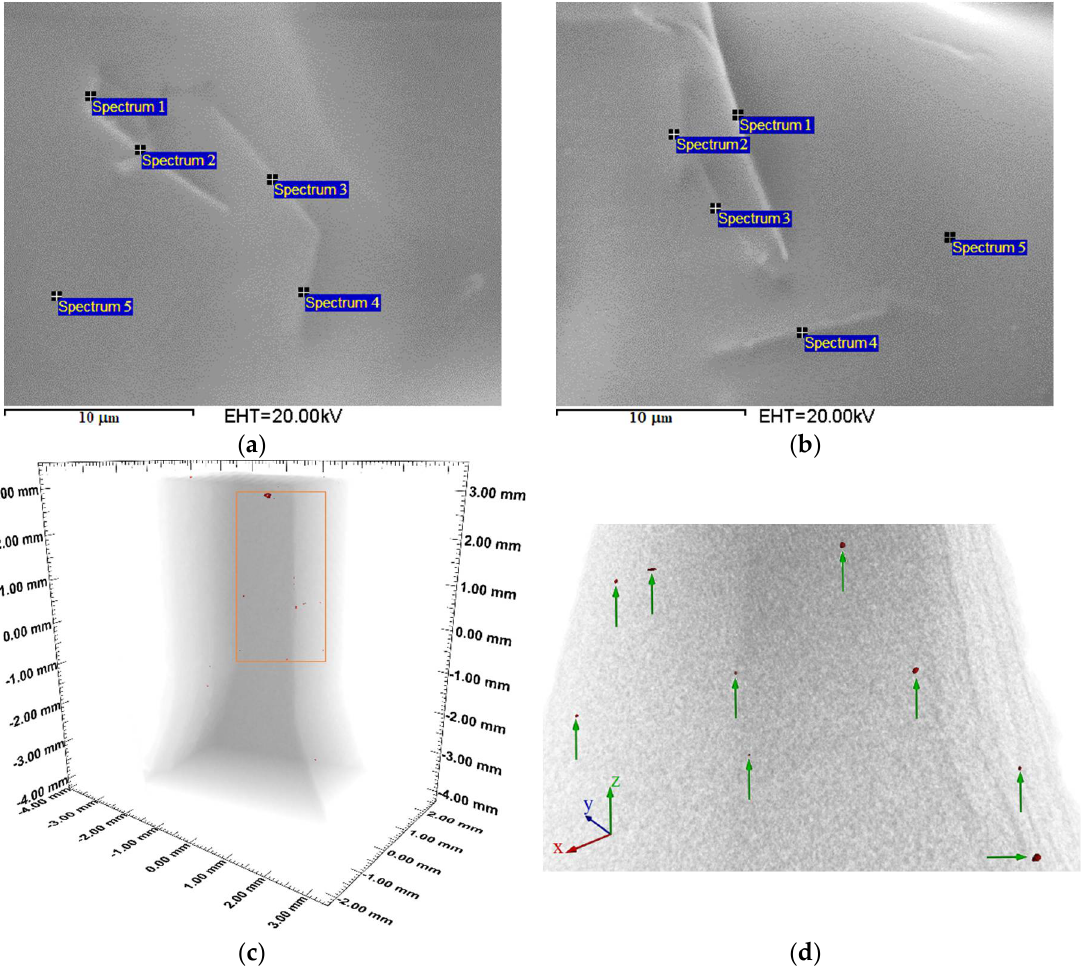
Figure 4. ( a ) Micrographs upon the built surface of a circular substrate with Cu NWs at 5.1% w / w . ( b ) Micrographs upon the built surface of a circular substrate with Cu NWs at 10.0% w / w . ( c , d ) 3D rendering of the substrate section that shows the Cu NWs distribution (rendered in red).